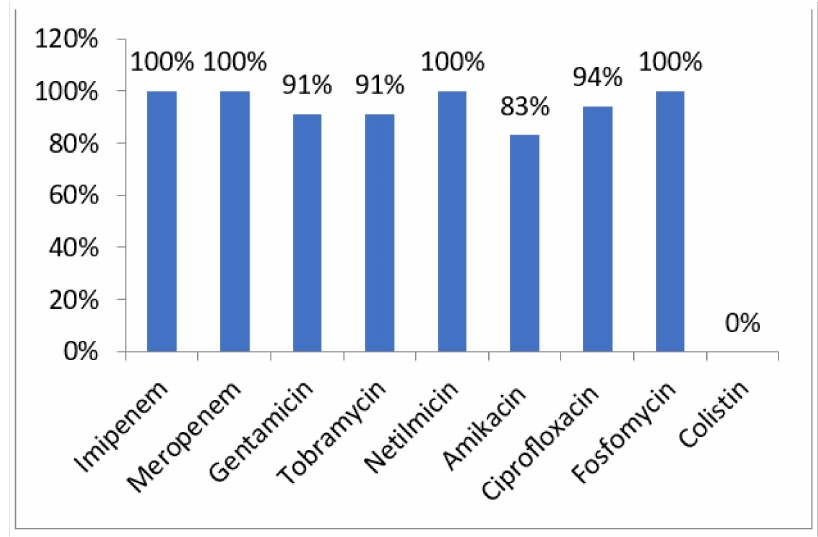
Figure 3. Antibiotic resistance rates among P.aeruginosa